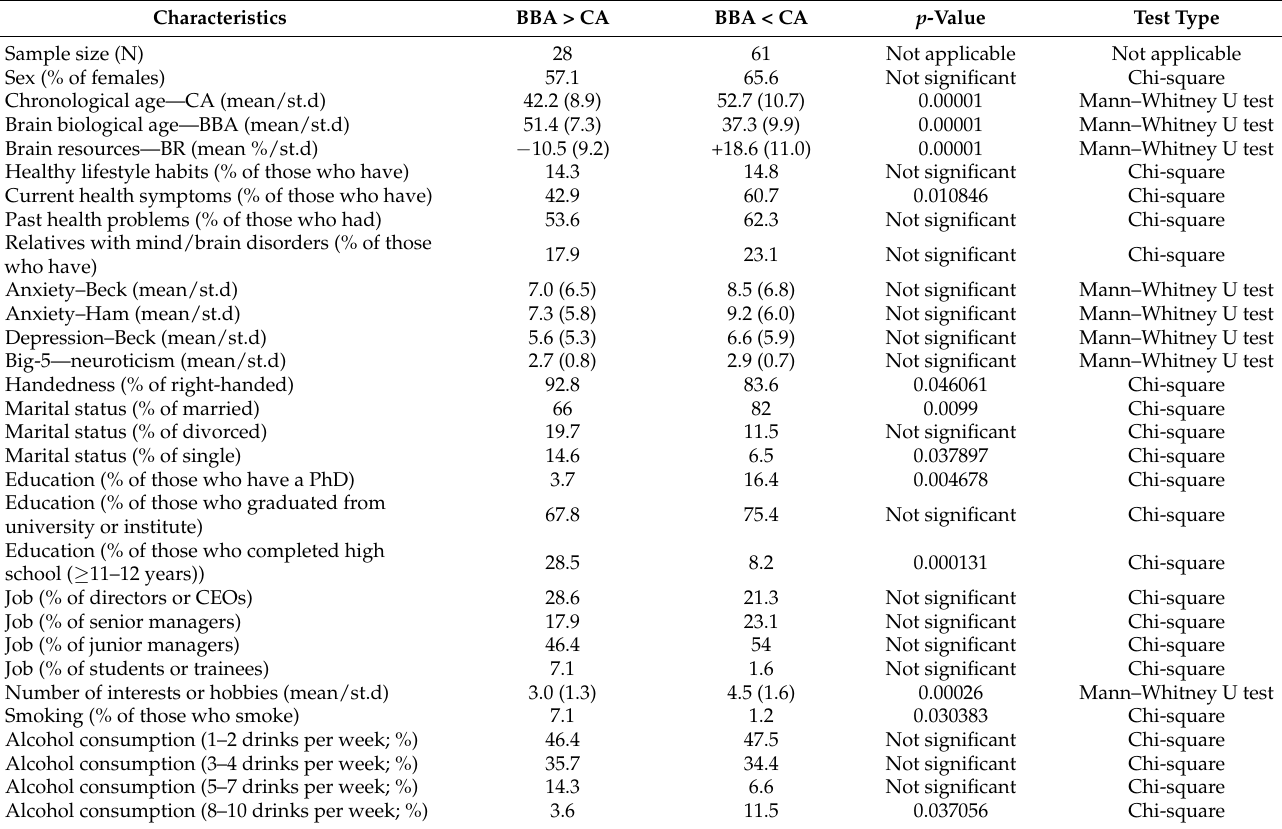
Table 2. Demographic and clinical data for the subgroups with the pre-intervention BBA older or younger than the